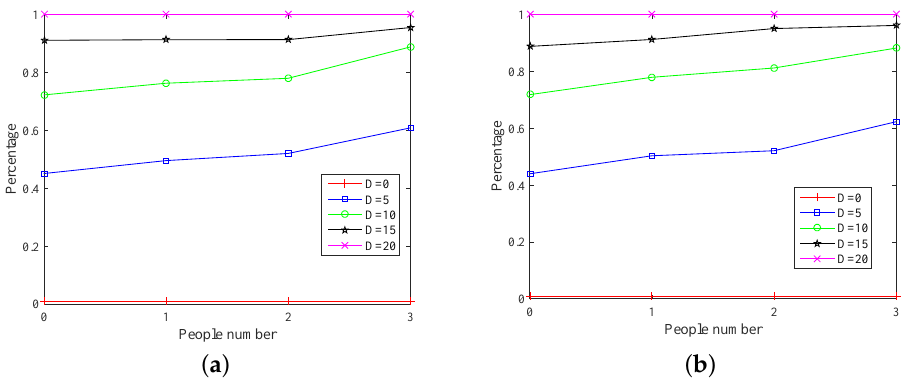
Figure 10. The impact on dilatation coefficient. ( a ) amplitude; ( b )